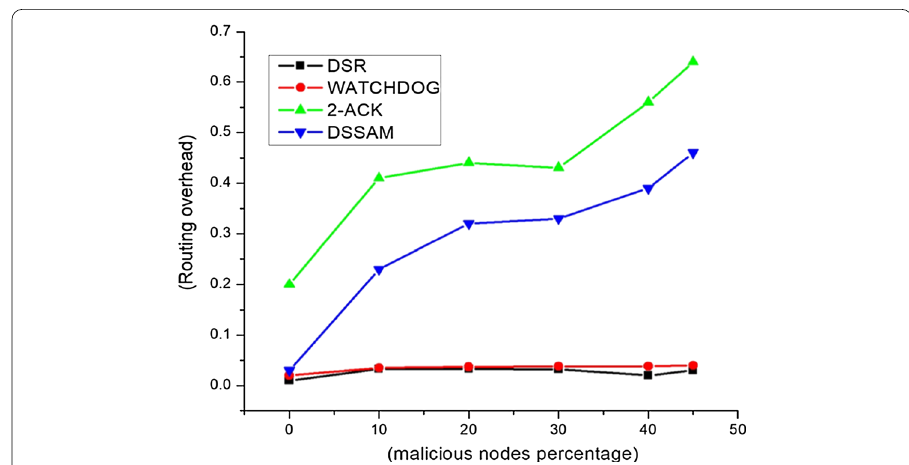
Fig. 12 Case 1-Routing Overhead